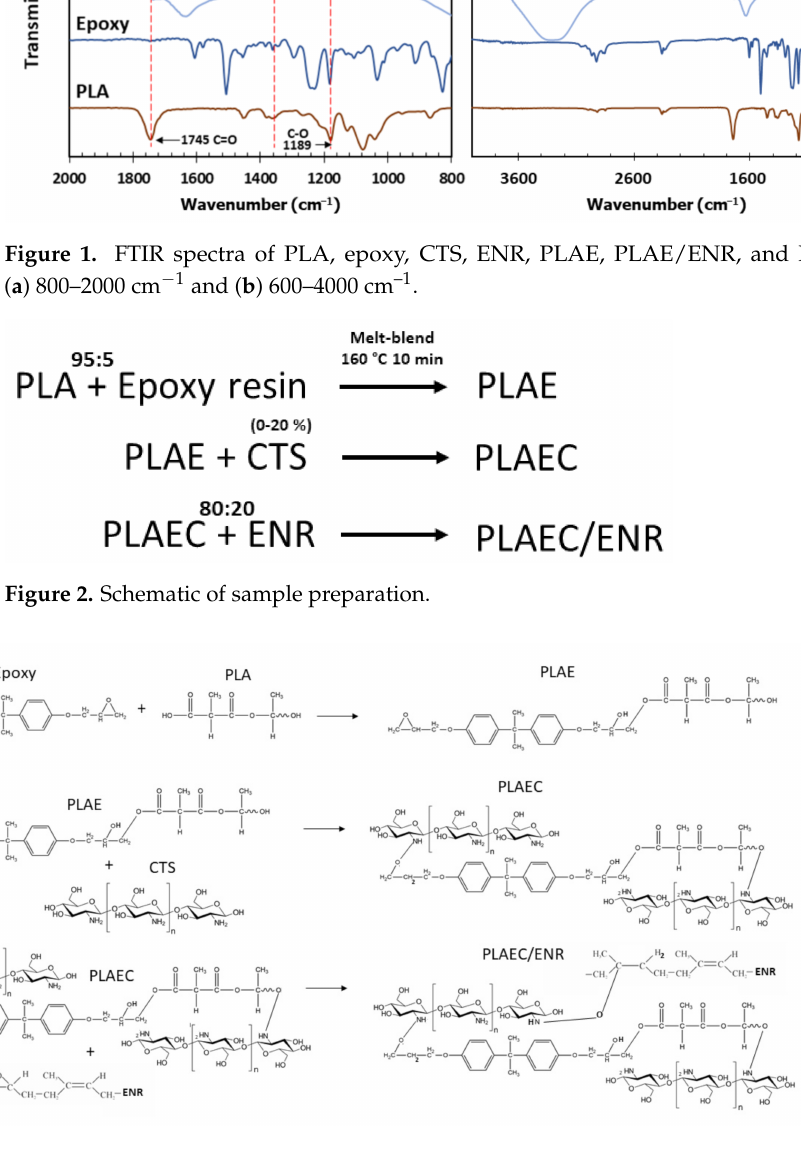
Figure 3. Suggested reactions of ( a ) epoxy and PLA, ( b ) PLAE and CTS, and ( c ) PLAEC and